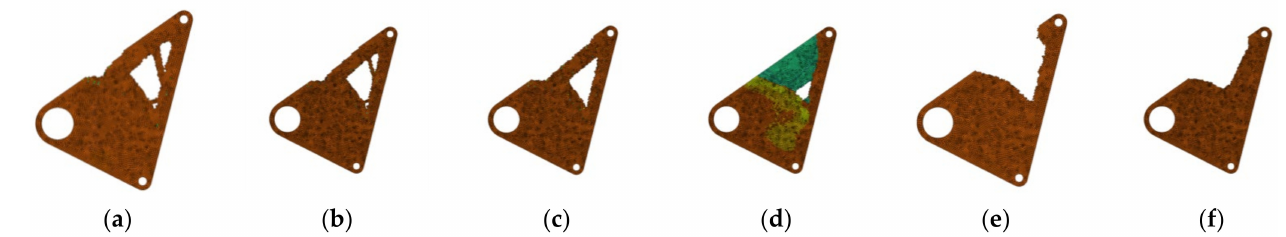
Figure 13. TO results for various manufacturing rates g . All elements whose design variable is greater than 0.1 are displayed. Additionally, the number of iterations until convergence is noted ( a ) g = 0.5 iterations: 87; ( b ) g = 0.6, iterations: 41; ( c ) g = 0.7 iterations = 41; ( d ) g = 0.8 iterations: 99; ( e ) g = 0.9 iterations: 99; and ( f ) g = 1.0 iterations: 100.